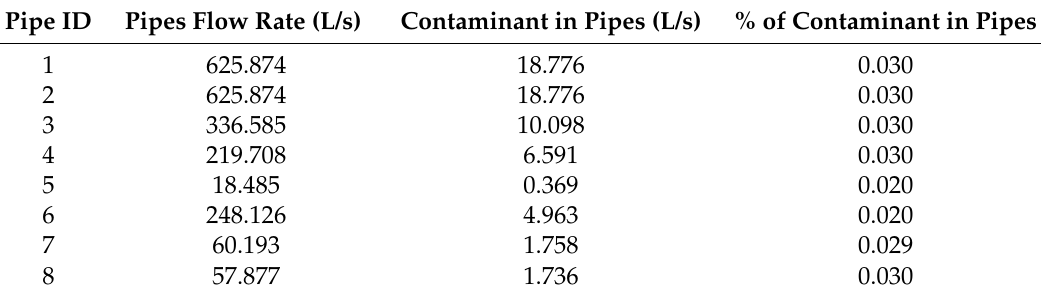
Table 2. Numerical results for pipe and contaminant flow for illustrative Example